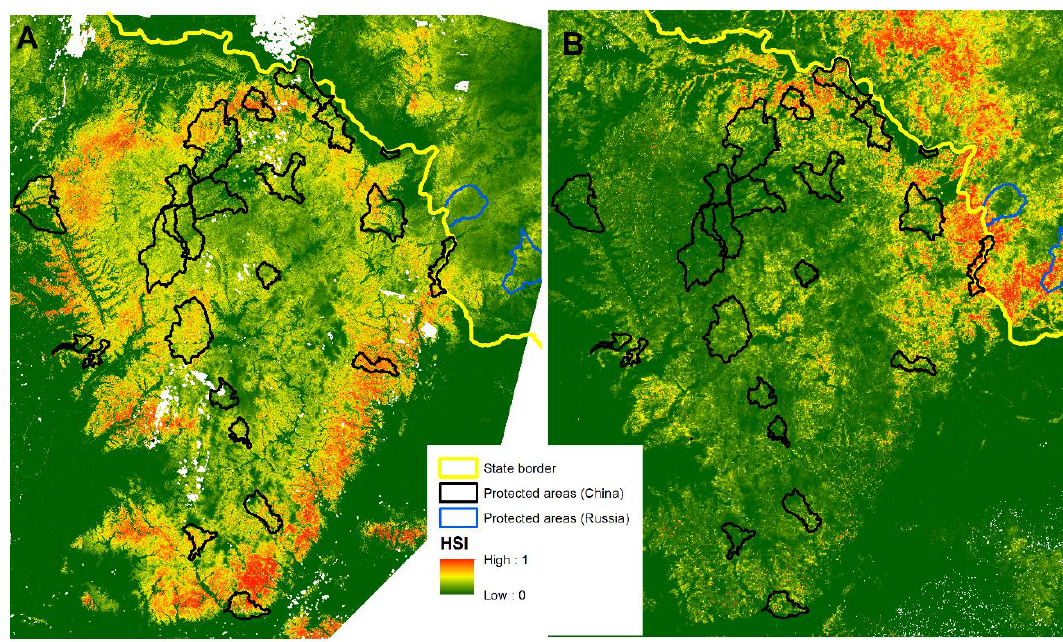
Figure A2. ( A ) Integrated prey-based MaxEnt model based on the Lesser Khingan winter track census survey, ( B ) MaxEnt model based on data from GPS-collars on tigers.